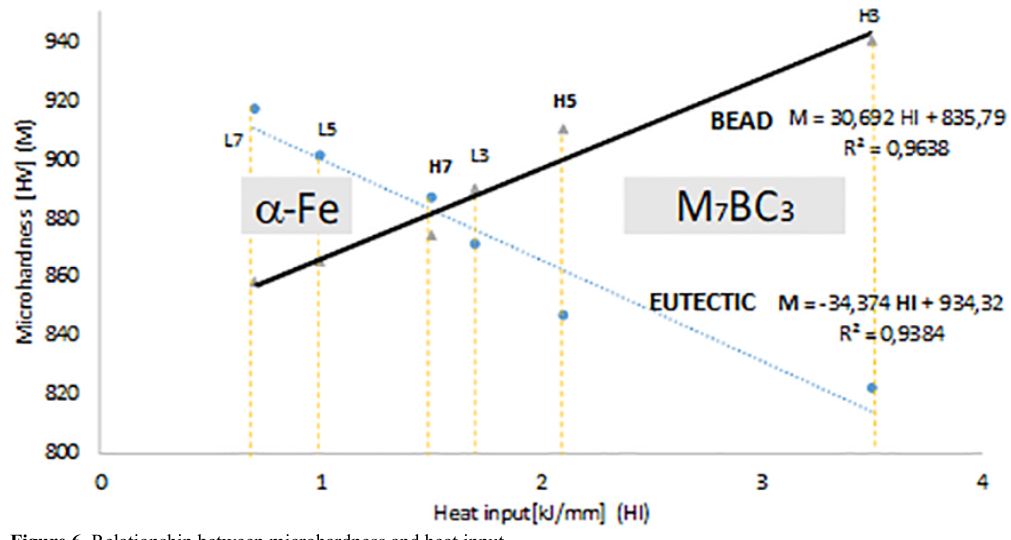
Figure 6. Relationship between microhardness and heat input.